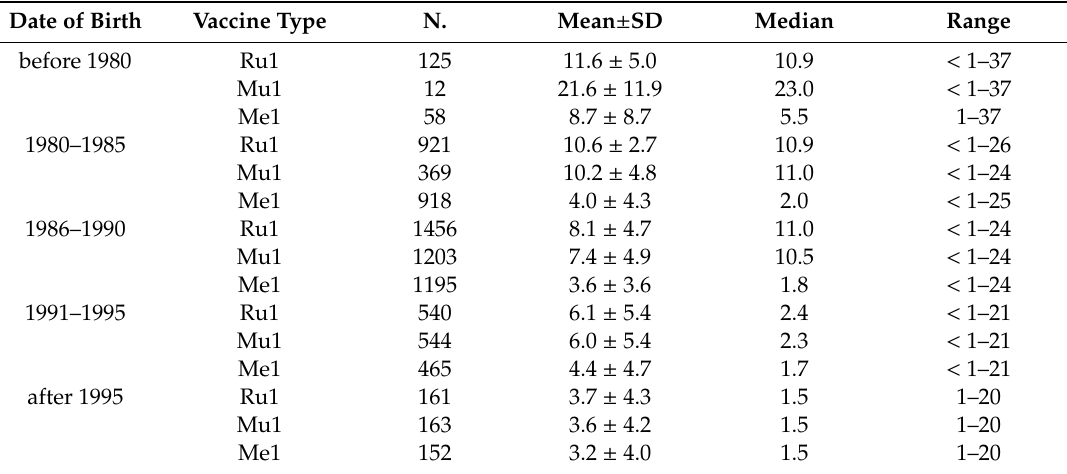
Table 4. Age of vaccination of students vaccinated once.